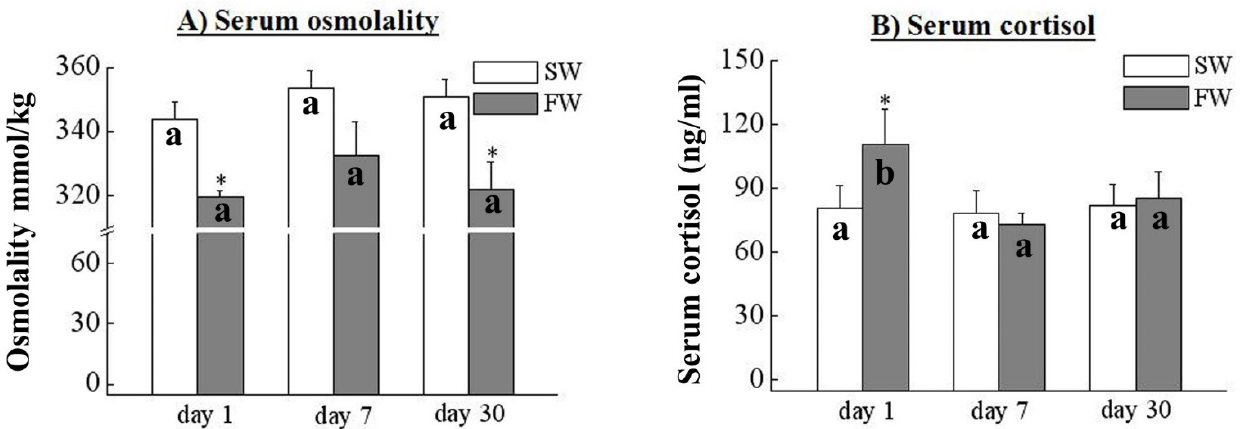
Figure 3. ( A ) Analysis of the serum osmolality and ( B ) serum cortisol in FW and SW black porgy on days 1, 7, and 30 ( n = 8, in each group). The results are expressed as mean ± SEM (standard error of mean). Different letters indicate significant a difference between sampling points with the same treatment; asterisks (*) show differences between groups at the same time points (two-way ANOVA followed by Tukey’s test, p < 0.05).